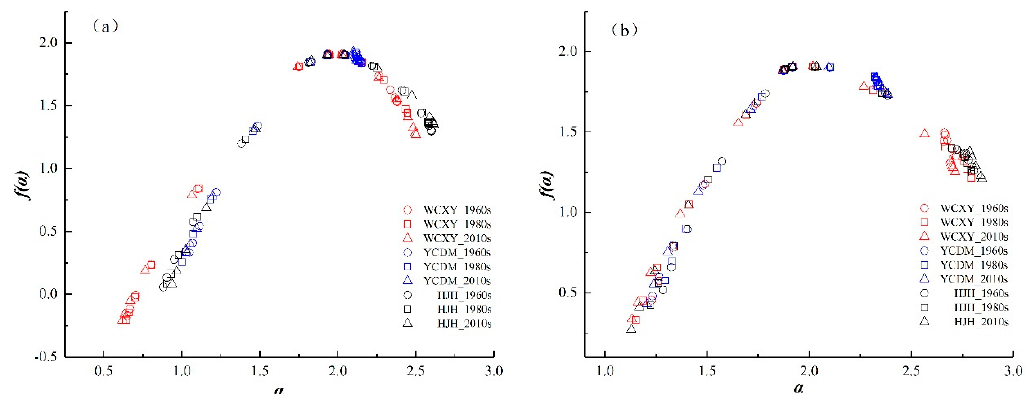
Figure 7. The multifractal spectrum of the Main Rivers (1st and 2nd order, ( a )) and Tributaries (3rd and 4th order, ( b )) in the 1960s, 1980s, and 2010s.